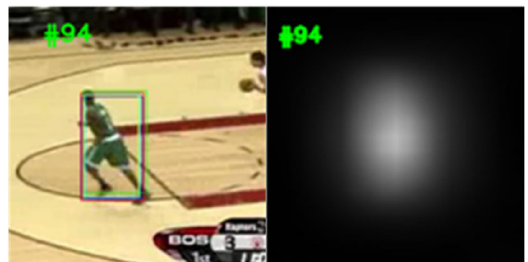
Figure 2. Similarity map without distractor .